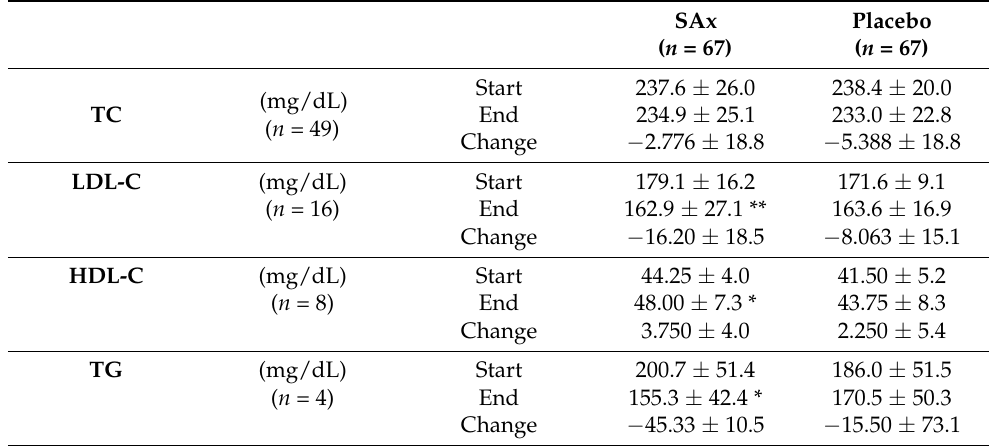
Table 3. Lipid-profile variables at the beginning and end of the supplementation and placebo periods in population with dyslipidemia.